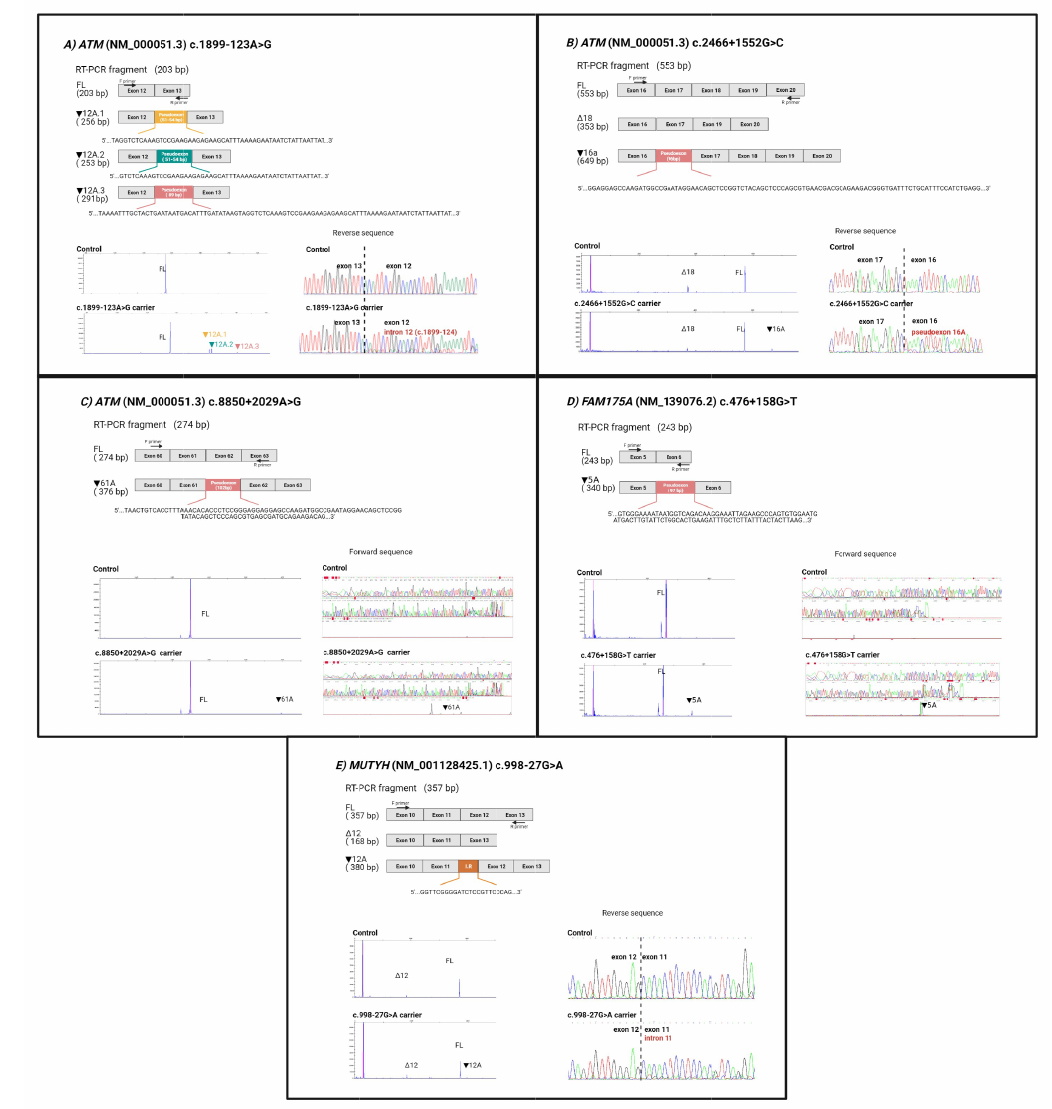
Figure 4. Spliceogenic variantscharacterization in patients’ RNA. For each variant, there is an RT-PCR assay graphical representation, the results of capillary electrophoresis of 6-FAM labelled amplicons and Sanger sequencing to confirm the expression of additional transcripts. ( A ) The ATM c.1899-123A > G variant activates a cryptic donor site, which is used to yield three different pseudoexons: (cid:72) 12A.1, (cid:72) 12A.2, and (cid:72) 12A.3, each generated as result of the usage of different cryptic acceptor sites (c.1899-174, c.1899-177, and c.1899-213) and the cryptic donor site created by the variant. The (cid:72)